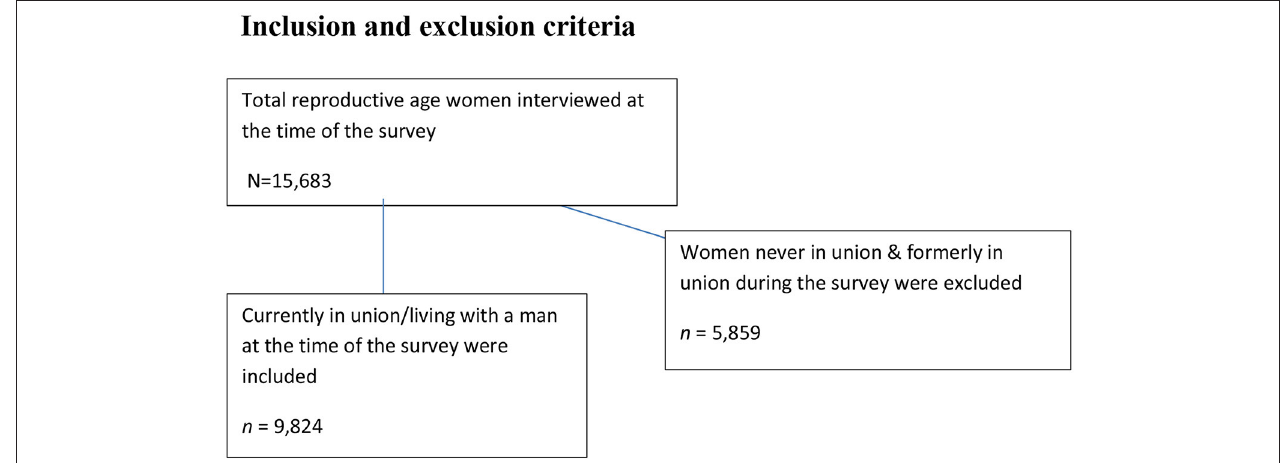
FIGURE 1 | Inclusion and exclusion